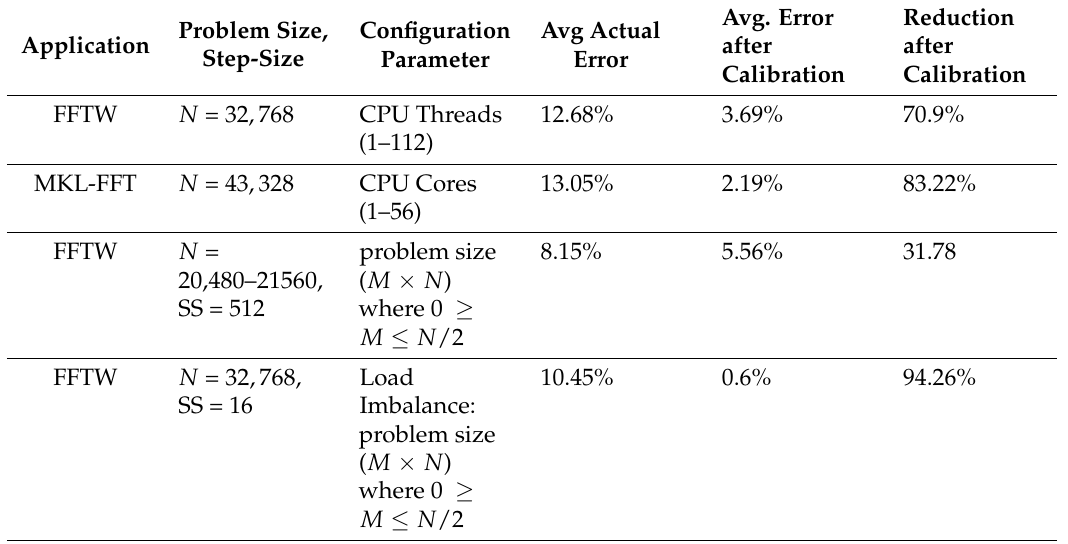
Table A1. Percentage error of dynamic energy consumption with RAPL and HCLWattsUp on HCLServer03. G = Threadgroups and T = Threads.